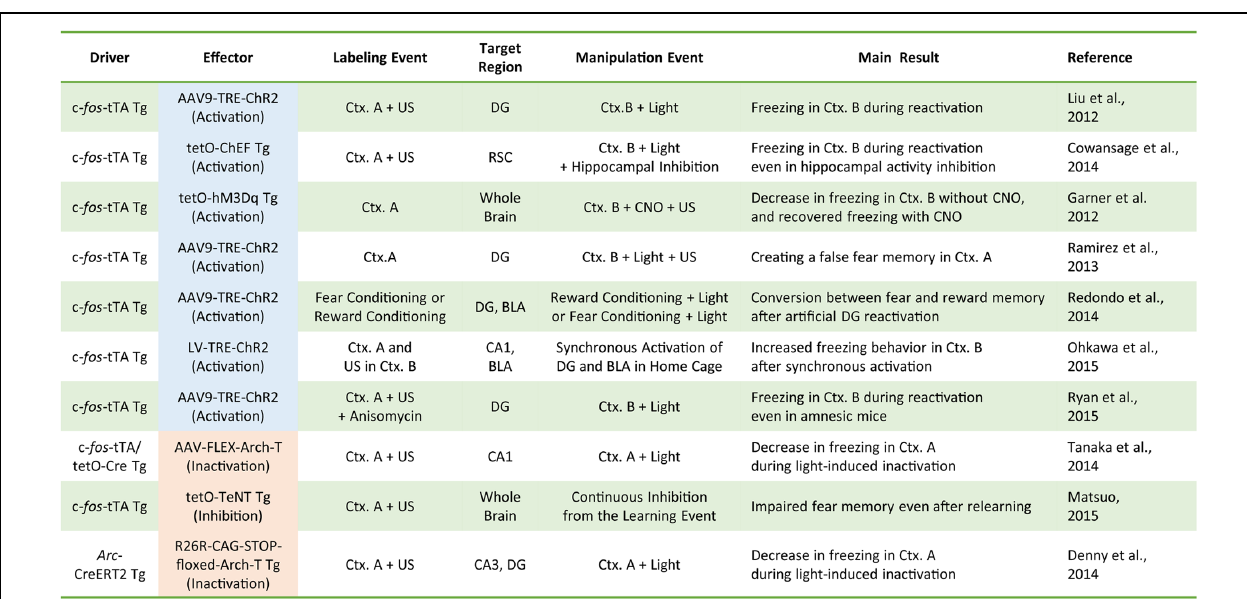
manipulation of IEG-expressing neurons. The seminal study by Liu et al. (2012) that demonstrated involvement of IEG- expressing neurons in the memory trace used two transgene components, c- fos -tTA transgenic (tg) mice and TRE-ChR2